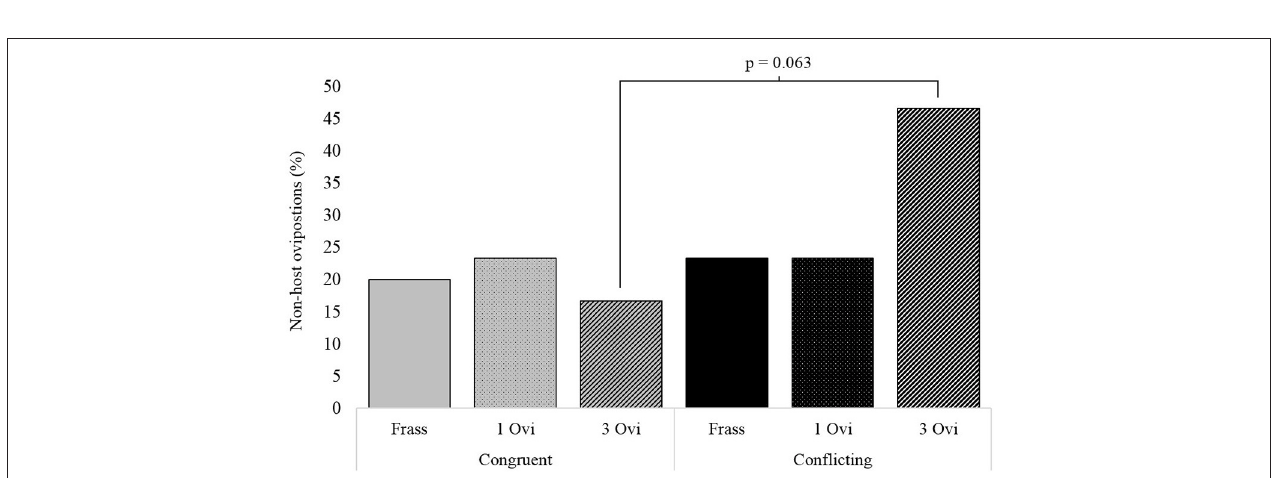
FIGURE 4 | The influence of foraging situation and conditioning treatment on the average time wasps spent on non-host patches. Conditioning treatments consisted of; a 20s host frass exposure (Frass), 1 oviposition (1 Ovi), or 3 spaced ovipositions (3 Ovi). Bars with different letters are significantly different ( n = 30, α = 0.05), error bars show the s.e.